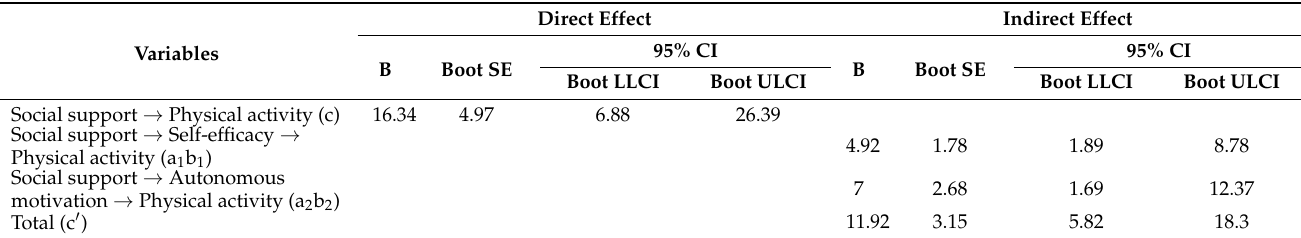
Table 4. Direct and indirect effect on physical activity (N = 190).